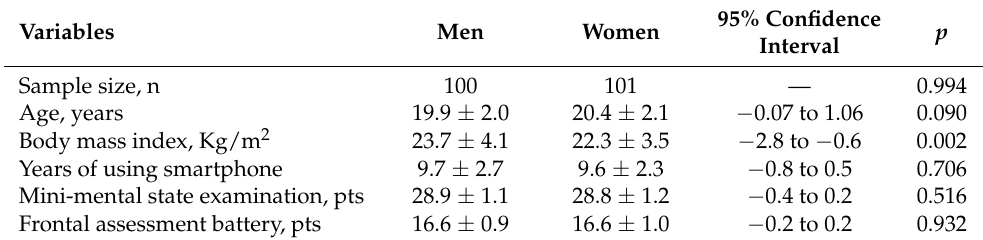
Table 1. General characteristics of the